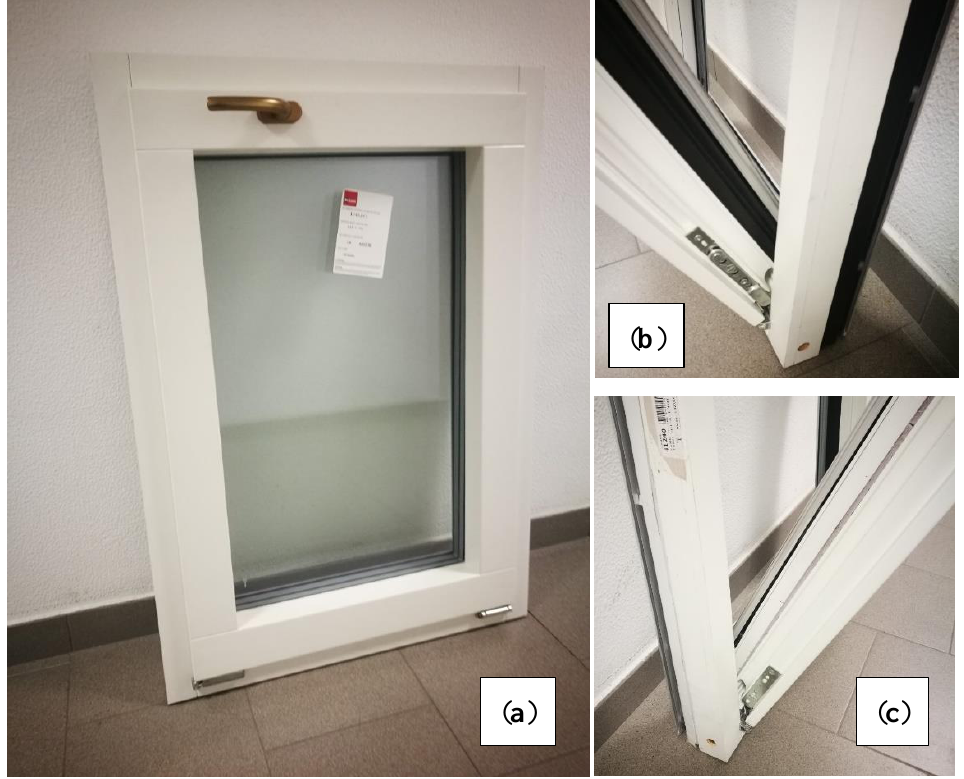
Figure 3. Aerogel-enhanced window (Aeroshield) embodying a triple-glazed unit, with external aluminium frame and internal wooden frame ( a ); Reference frame with expanded polystyrene insulation, in black (b); Aerogel-insulated frame with polymer skin ( c ).